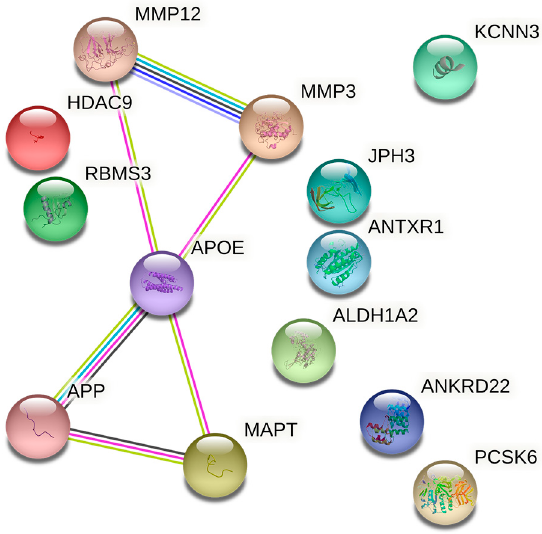
Figure 2. The protein-protein interaction network of APP, MAPT, ApoE, and thirteen common protein coding susceptibility genes products (confidence score ≥ 0.4). MMP3 and MMP12 link with ApoE. Abbreviation: ApoE: apolipoprotein E; APP: amyloid precursor protein; MAPT: microtu- bule associated protein tau; MMP12: matrix metalloproteinase 12; MMP3: matrix metalloprotein- ase